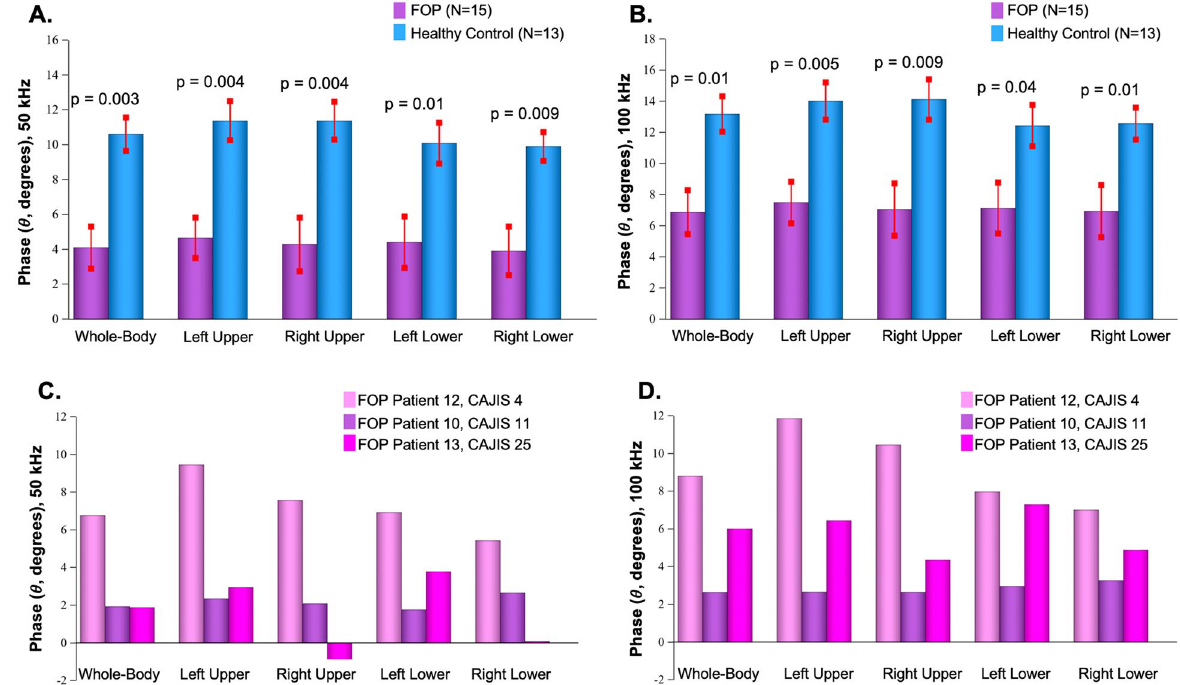
Figure 3. Whole-body and regional phase in patients with FOP and healthy controls. The mean ± standard error (SE) phase ( θ ) values for whole-body and regional (left upper, right upper, left lower, and right lower) assessments are compared between FOP and healthy control cohorts at 50 kHz ( A ) and 100 kHz ( B ). At both frequencies as well as for whole-body or regional assessments, mean θ values were consistently lower in the FOP cohort relative to healthy control population. P-values (two-tailed) are reported from Wilcoxon two-sample test. Effect size range for 50 kHz: 1.13–1.58. Effect size range for 100 kHz: 0.95–1.36. Group-level findings for reactance ( X ) and resistance ( R ) values are provided in Table 2. The mean θ values are reported at 50 kHz ( C ) and 100 kHz ( D ) at whole body and regional (left upper, right upper, left lower, and right lower) levels for three male FOP patients with varying CAJIS scores. Across muscle groups, θ was consistently higher in FOP patient 12 (CAJIS score 4) when compared to those with higher CAJIS scores. At 50 kHz in particular, EIM was able to differentiate between more severely afflicted muscle regions, as indicated by lower θ , and regions with healthier unaffected muscle. This suggests that EIM is capable of detecting regional changes in muscle tissue integrity in